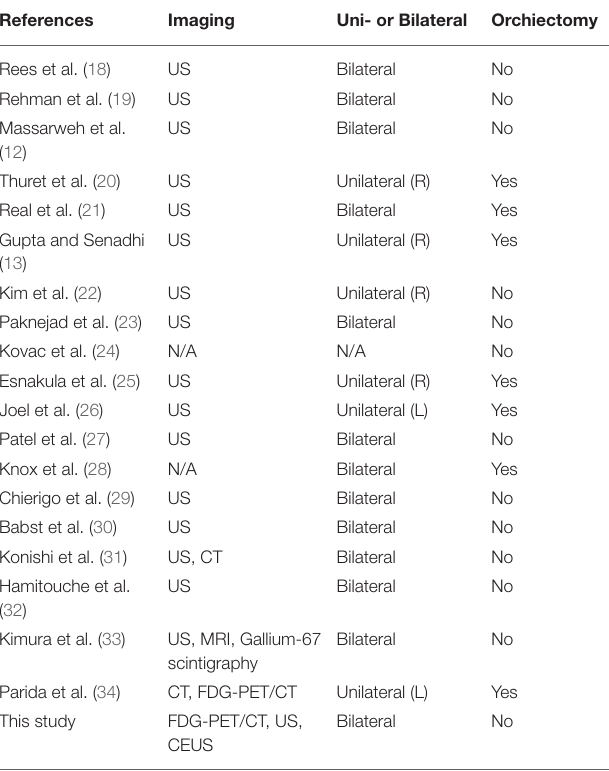
TABLE 1 | Histologically proven cases of sarcoidosis involving the testis reported in the English literature from 2004 to 2020 (including the present case).